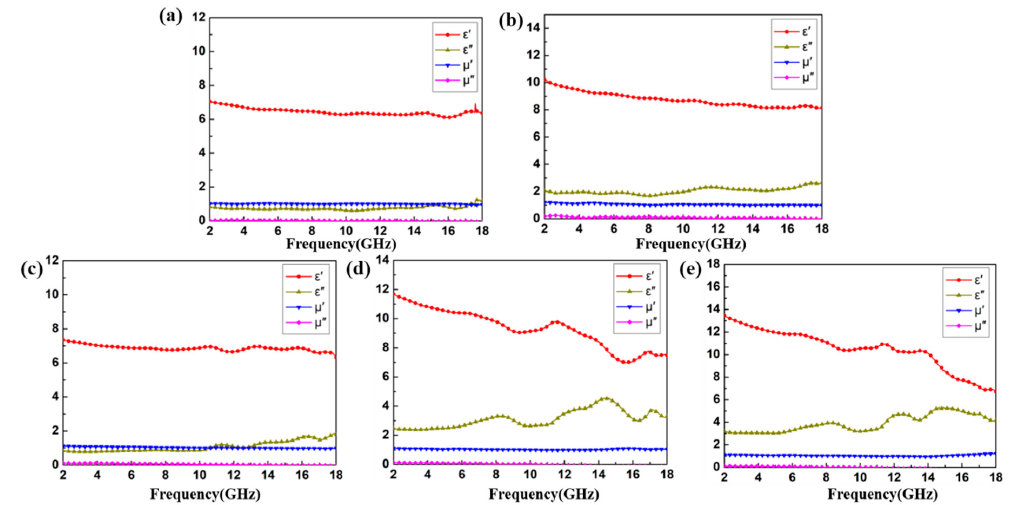
Figure 7. Real and imaginary parts of the complex permittivity and permeability of Ti 3 C 2 T x (35 wt %) ( a ), CoS (35 wt %) ( b ), CoS@Ti 3 C 2 T x (35 wt %) ( c ), CoS@Ti 3 C 2 T x (40 wt %) ( d ), and CoS@Ti 3 C 2 T x (45 wt %) ( e ).